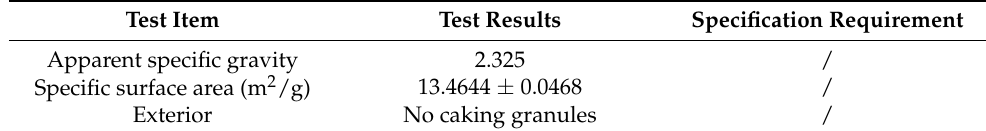
Table 8. Physical properties of slaked lime.